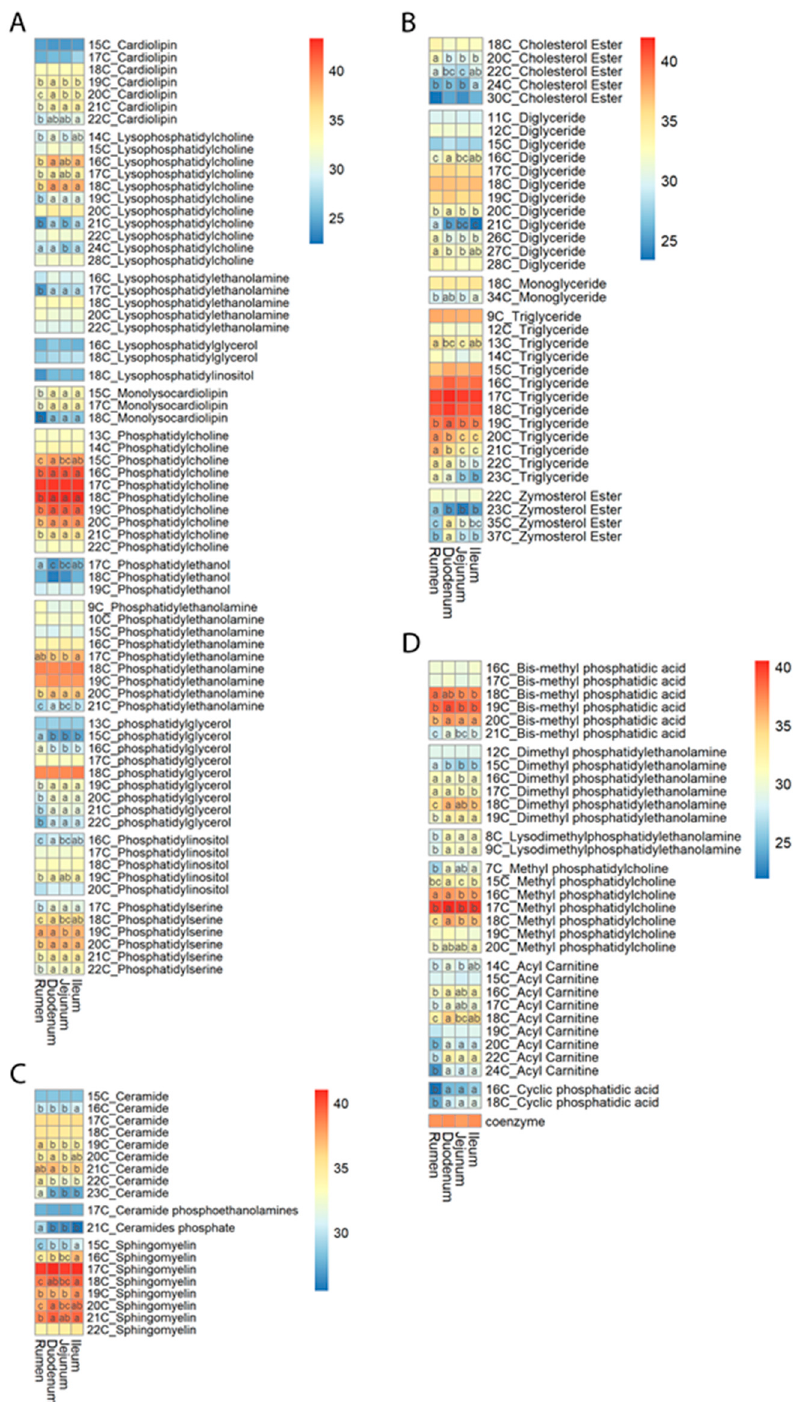
Figure 3. Signal counts of average fatty acid chain length in each lipid class across the ruminal papillae and epithelium from duodenum, jejunum, and ileum of 5 lactating Holstein cows (( A ): phospholipids, ( B ) neutral lipids, ( C ) sphingolipids, ( D ) derivatized lipids, fatty acyl, and other lipids). The letter C and a number denote the average fatty acid chain length. Red denotes high signal counts, yellow median signal counts, and blue low signal counts in each lipid class. a,b,c Means with on the same row differ ( p < 0.05).